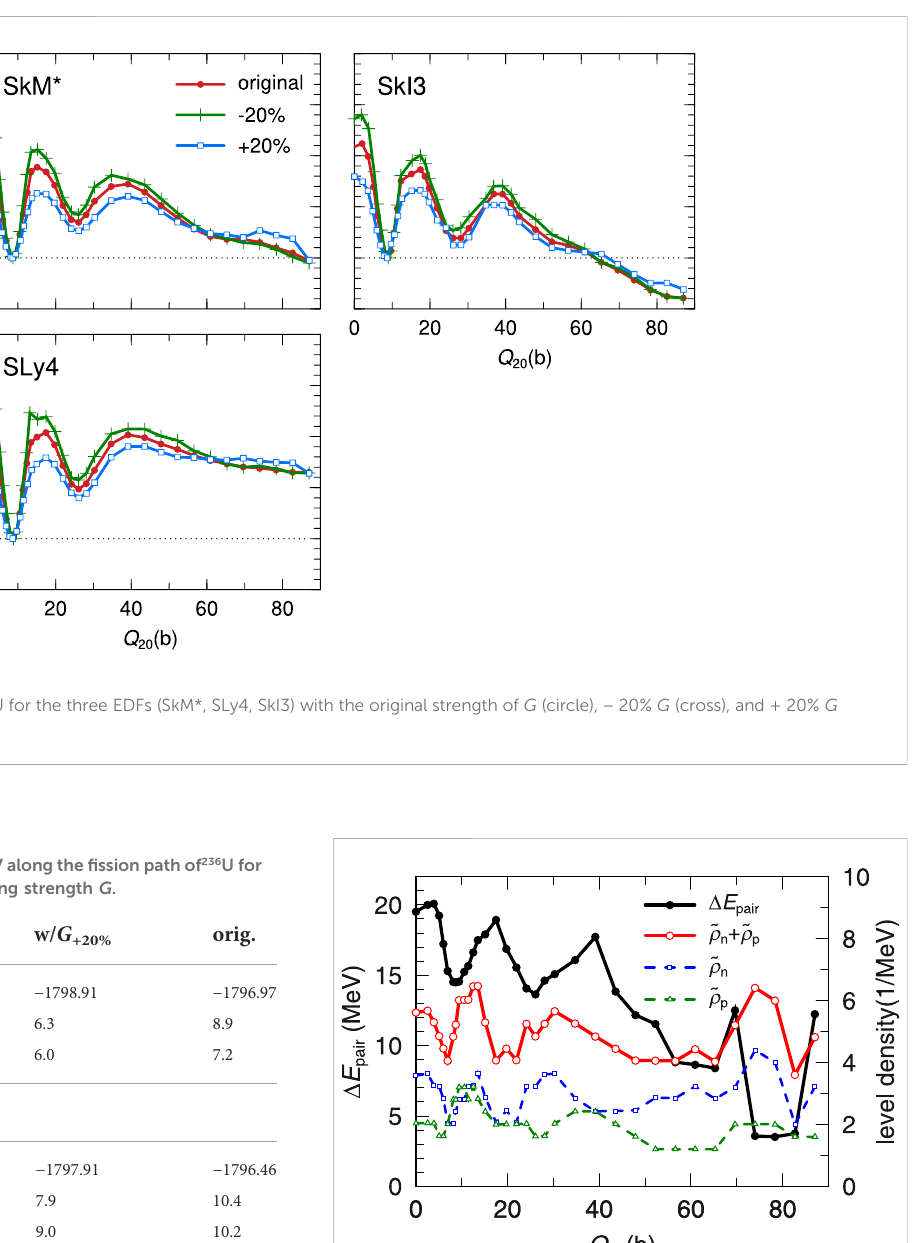
FIGURE 6 The local level densities ~ ρ for neutron and proton, and Δ E pair along the fi ssion path of 236 U calculated with SkM*. The left and right vertical axes represent Δ E pair , and ~ ρ ,